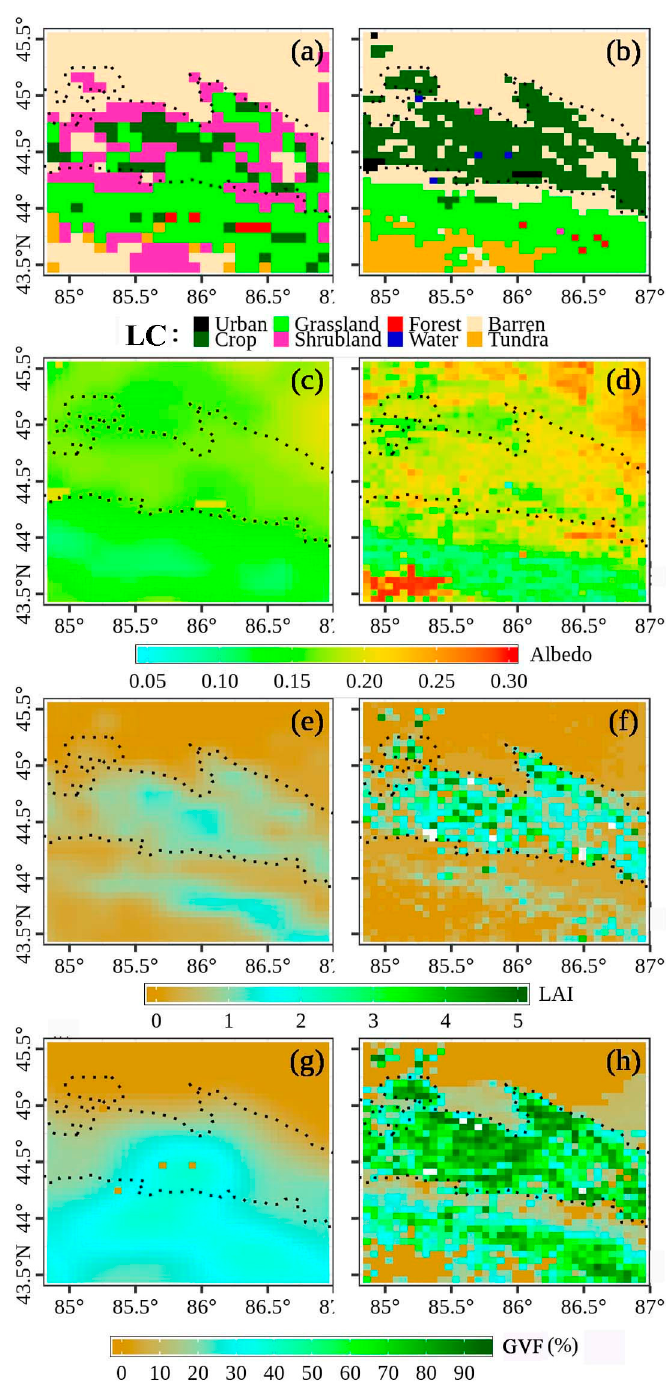
Figure 2. Comparison of ( a ) default LC, ( c ) albedo, ( e ) LAI and ( g ) GVF datasets and the corresponding actual datasets ( b , d , f , h ). From top to bottom: land cover (LC), albedo, leaf area index (LAI) and green vegetation fraction (GVF).